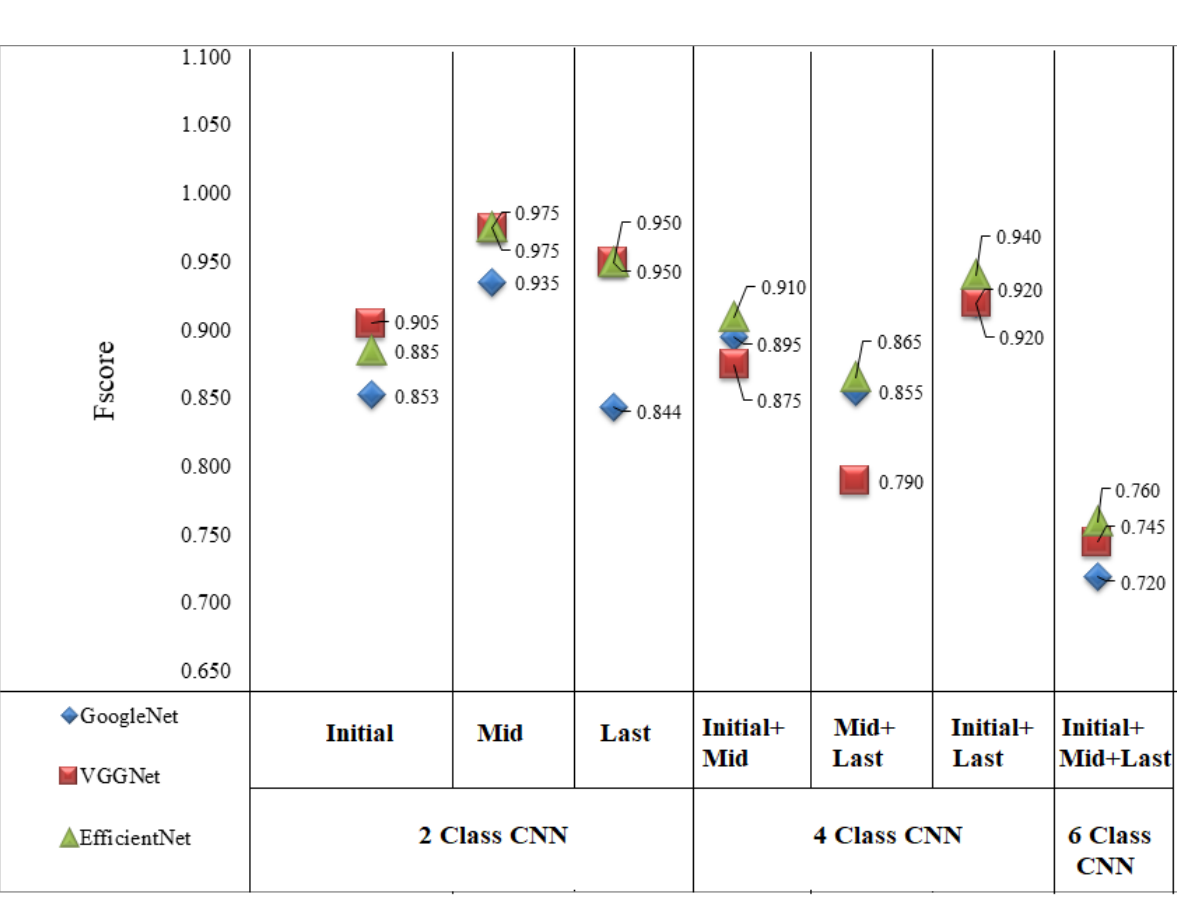
Figure 6. FScore comparison of various convolutional neural networks to evaluate their performance accuracy in early blight disease detection in the potato cropping system.